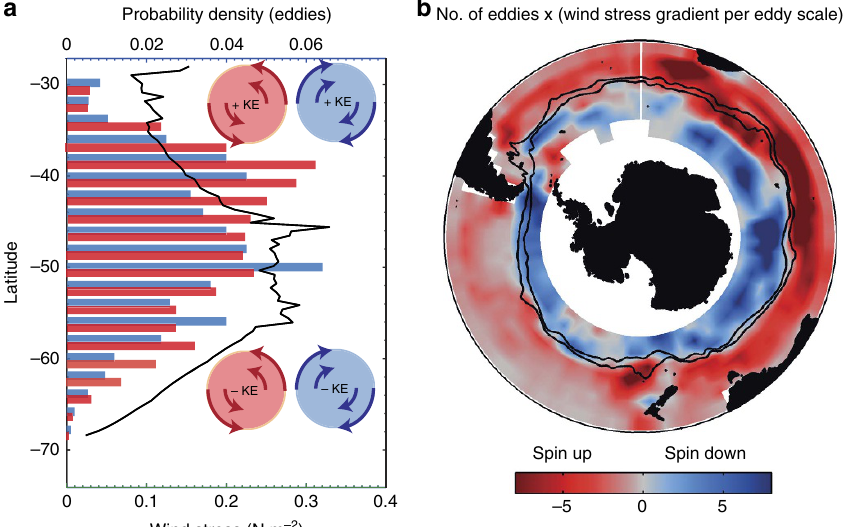
Figure 4 | Satellite observations and regions for the mesoscale thermodynamic pathway. ( a ) Normalized probability distribution of warm (red)- and cold (blue)-core eddies as a function of latitude compared with the mean, time-integrated wind stress (black solid line). ( b ) Southern Ocean map of the product of the average wind stress gradient across an eddy within each 4 (cid:2) (longitude) times 2 (cid:2) (latitude) grid box and the number of eddies within this box. The wind stress was computed from SeaWinds on QuikSCATand the eddies were identified from satellite sea surface height anomaly data (AVISO) over the period June 2002 to November 2009 (see Methods); shown are only values that are significantly different from 0 at the 1% confidence level (as judged by a t -test). The mean positions of the Subantarctic and Polar Fronts are shown as solid black lines; reddish colours show anticyclonic (negative gradient) wind shear situations, bluish colours show cyclonic (positive gradient) wind shear situations; the former represent ‘spin-up’ conditions with respect to the coupling effect discussed here and the latter represent ‘spin-down’